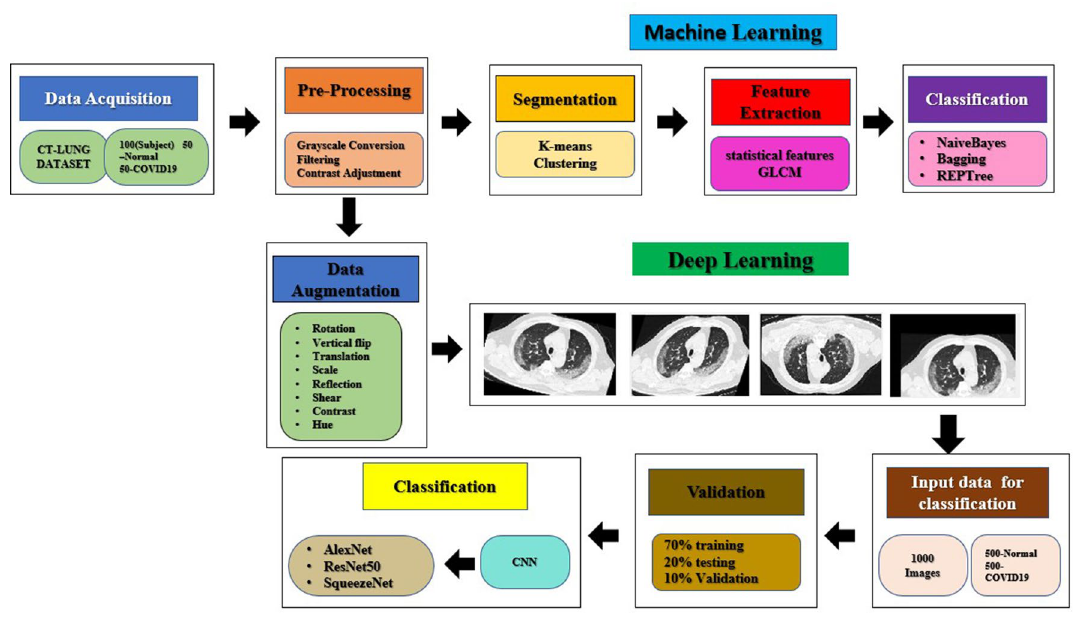
Figure 6. Block diagram of the proposed